Question: Based on the figure, does the quantity rise or fall?
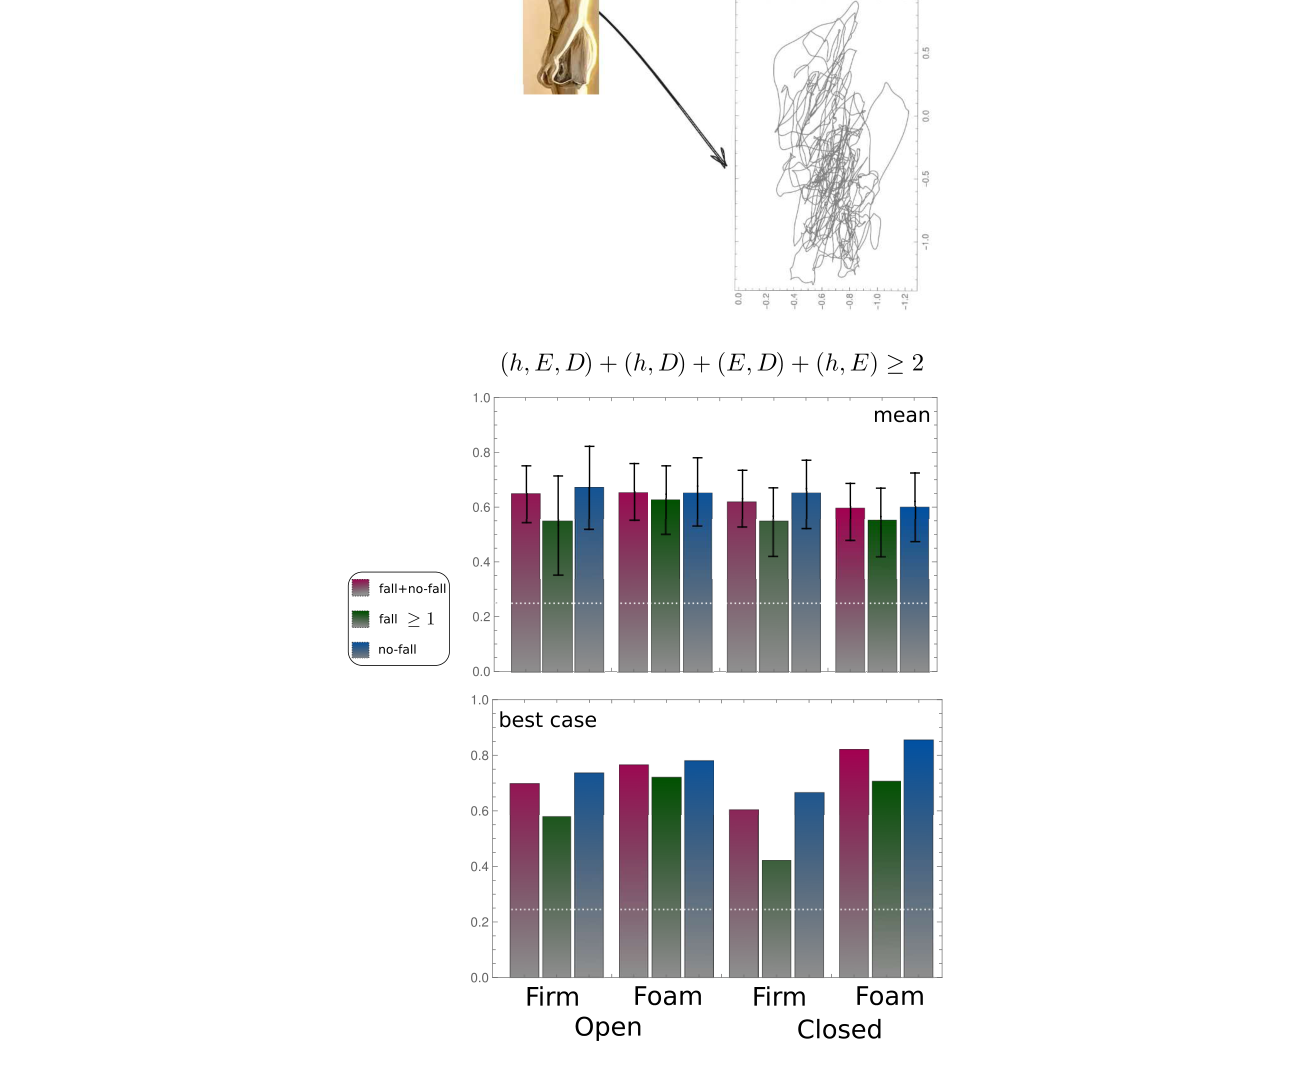
Answer: decreasing